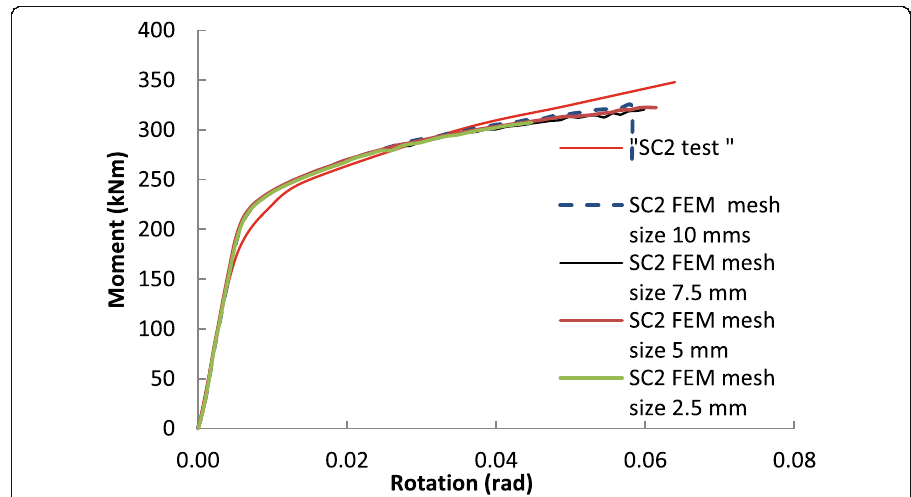
Fig. 6 Mesh sensitivity for M-Ø curve for connection